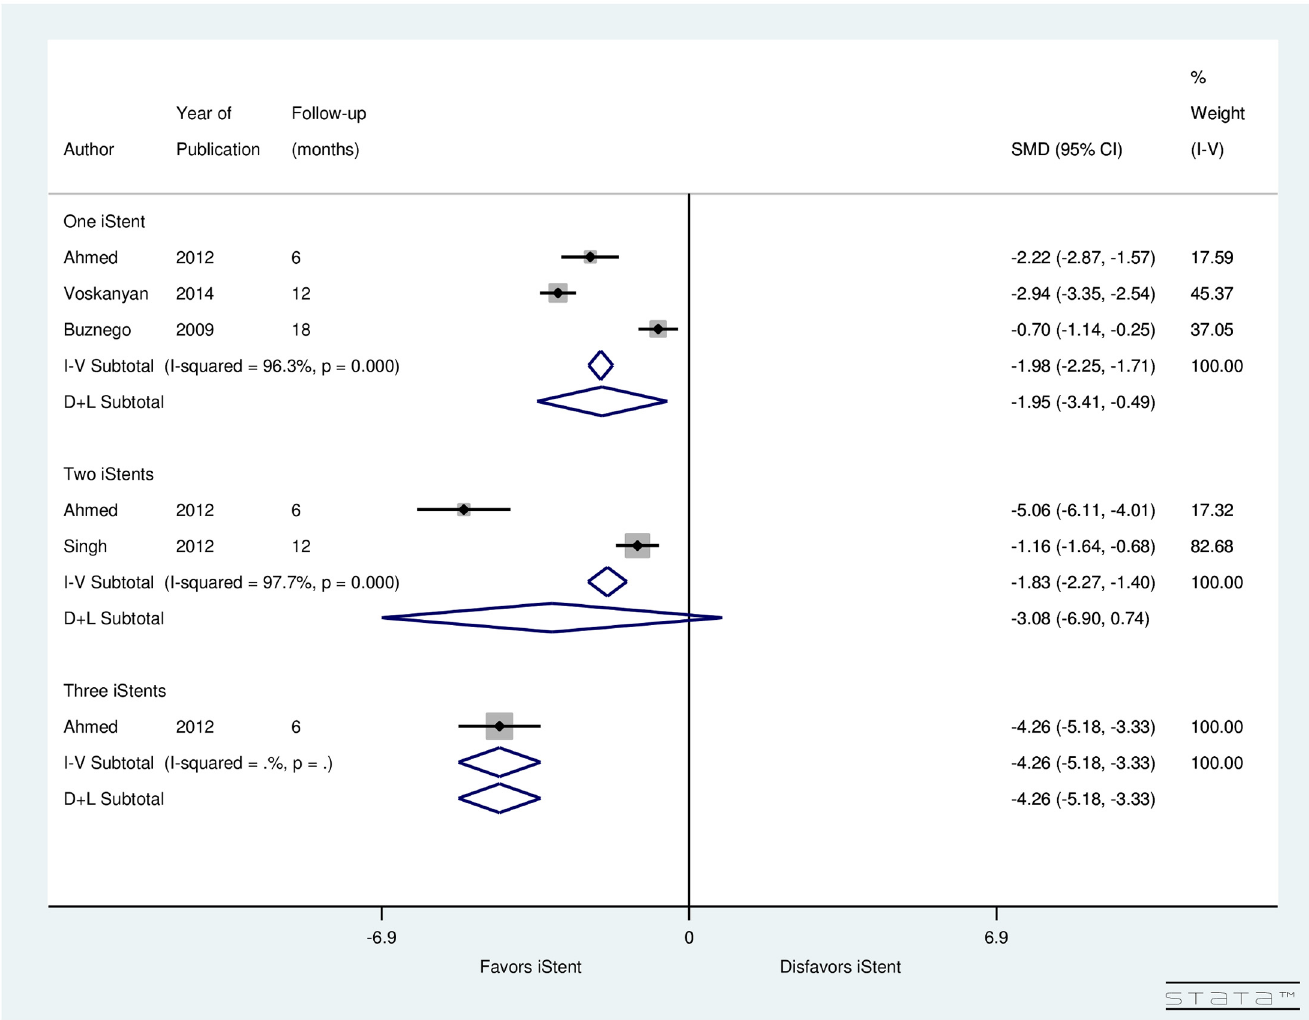
Fig 6. Forest plot for pre- and post-operative IOP by number of iStents